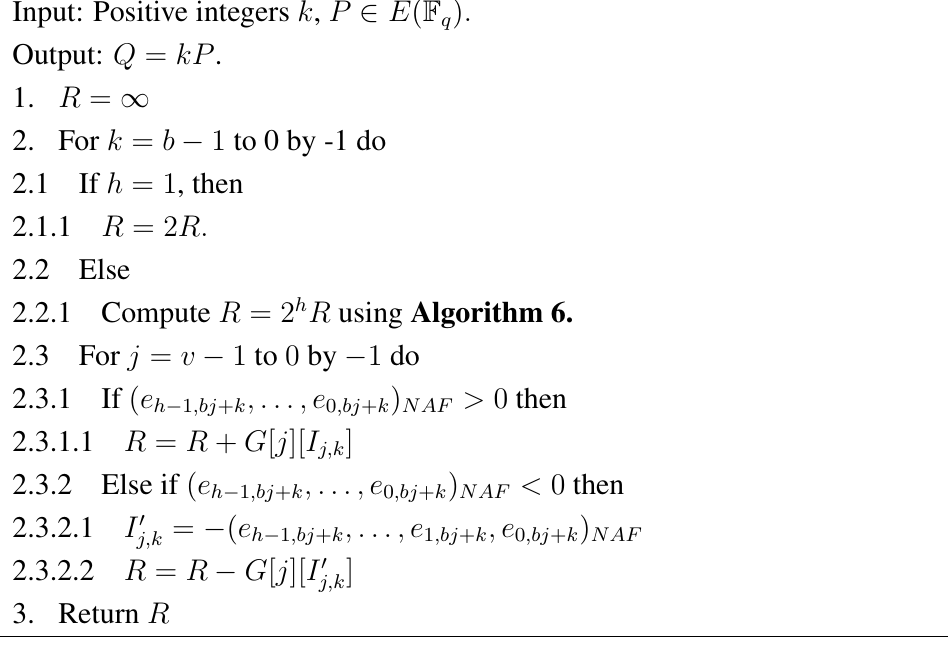
Algorithm 5. Tsaur and Chou’s method for scalar multiplication.